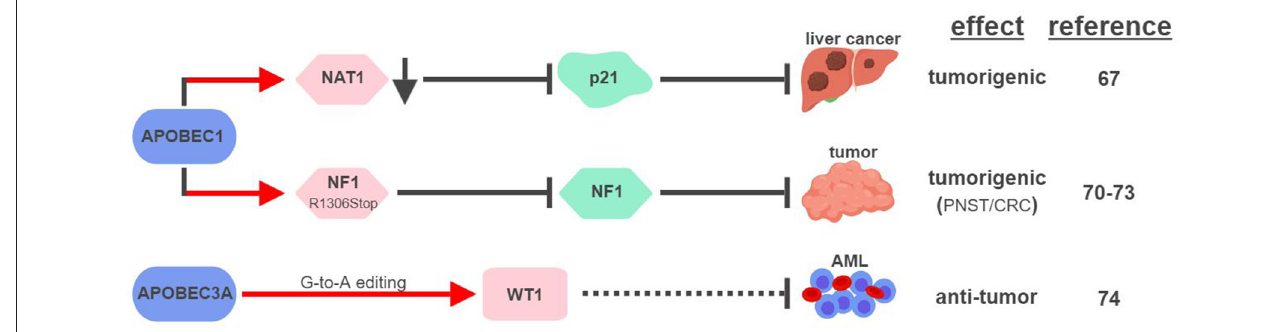
FIGURE 4 | APOBECs-mediated RNA editing in cancer development. The color of the first arrow in each pathway indicates the mechanism (refer to Figure 1 ) by which APOBECs regulates its direct targets, depicted in pink shapes. Dashed lines indicate suggested/unproven functions/relationships. CRC, colorectal cancer; PNST, peripheral nerve-sheath tumor; AML, acute myeloid leukemia. The figure was created with BioRender.